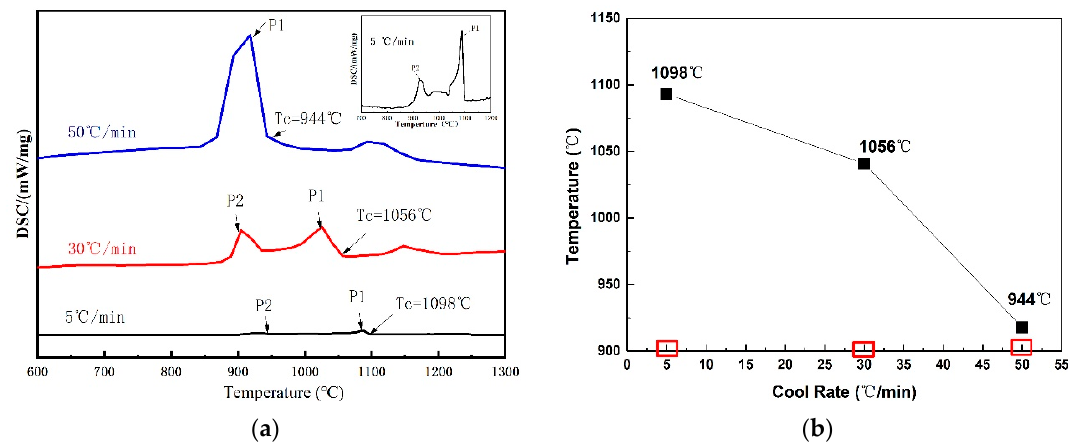
Figure 3. ( a ) Differential scanning calorimetry (DSC) curves of the non-isothermal crystallization of